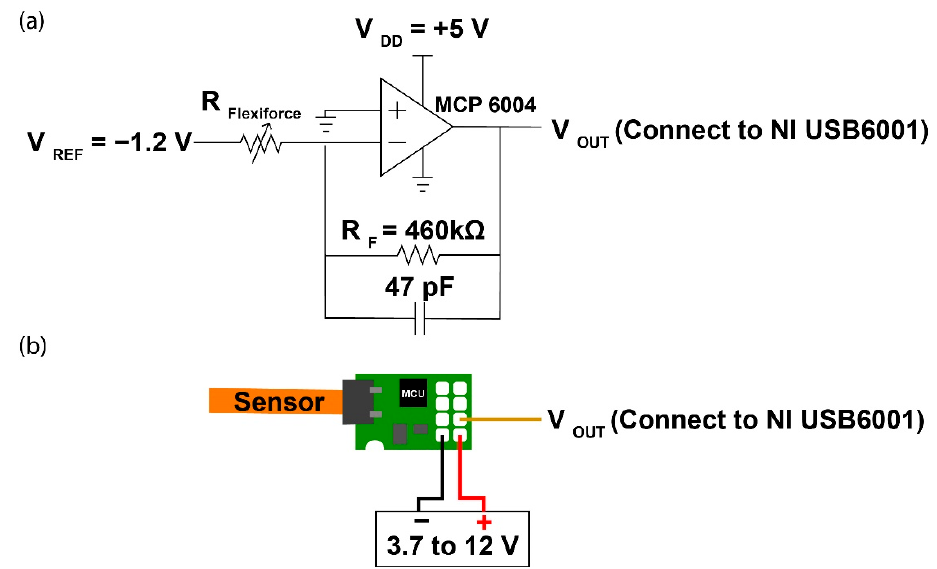
Figure 3. ( a ) Circuit for FlexiForce ® sensor, and ( b ) Pinout diagram of SingleTact